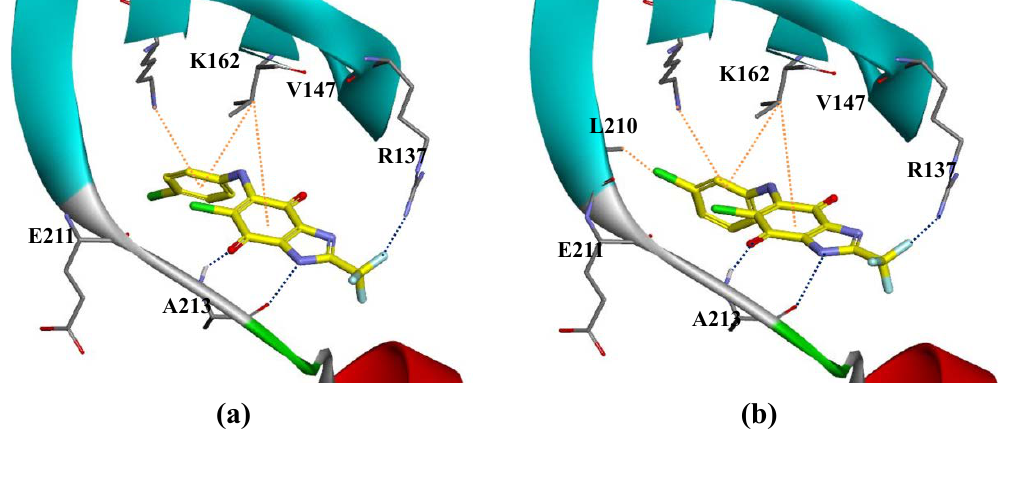
Figure 2. The binding mode of two compounds: ( a ) Compound 16 ; and ( b ) Compound 17 (PDB code: 3P9J). Hydrogen bond is shown in blue dotted line and π-interaction is shown in orange dotted